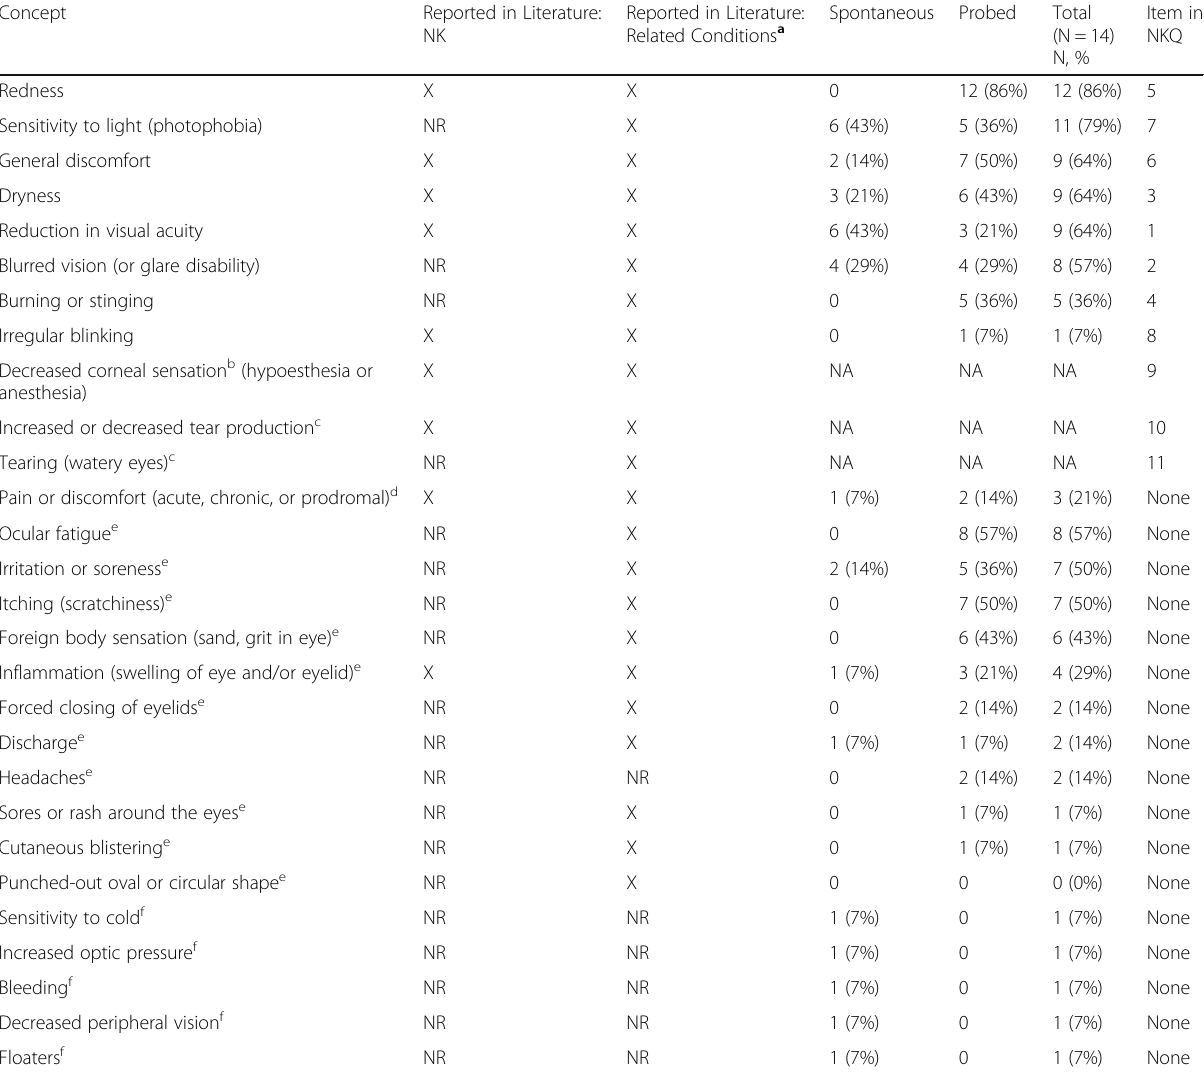
Table 4 Concept Comparison across Literature and Patient